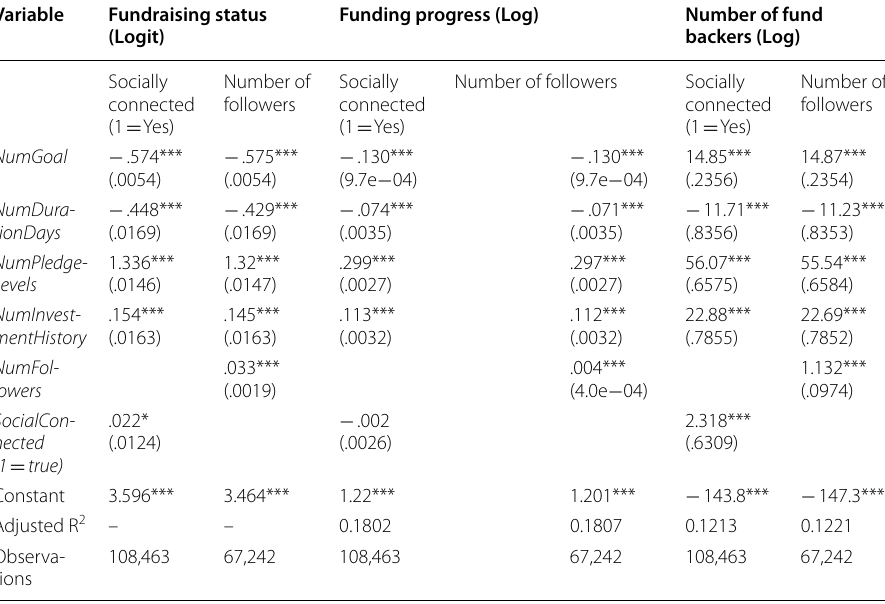
Table 6 Effect of external social connections on crowdfunding fundraising